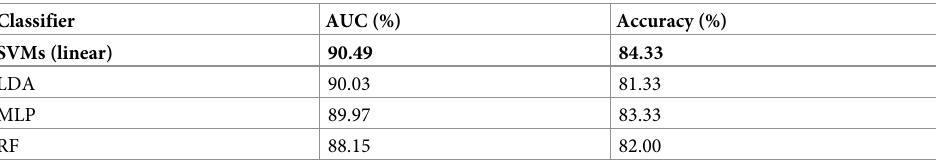
Table 2. Performance evaluation of the four classifiers on the test